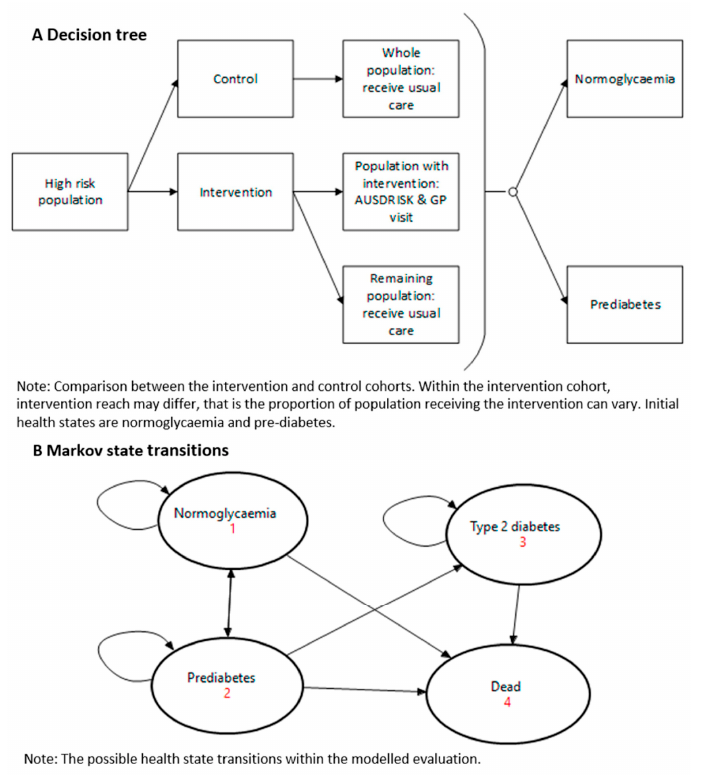
Figure 1. Model structure ( A ) of the decision tree component and ( B ) of the Markov component) for assessing the